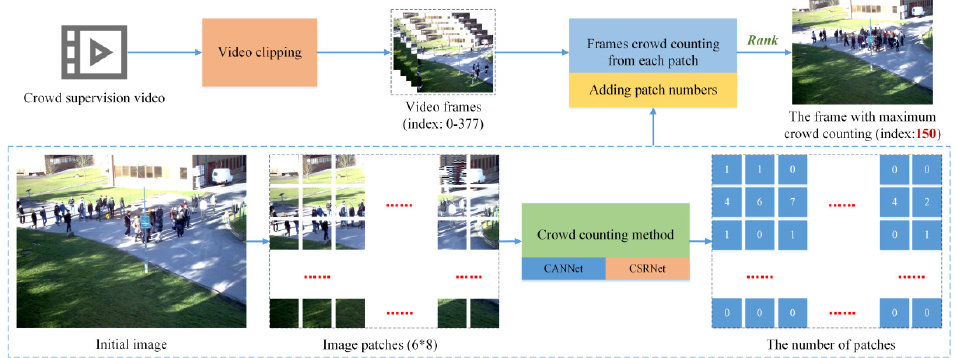
Figure 2. DCFG for finding the candidate frame.